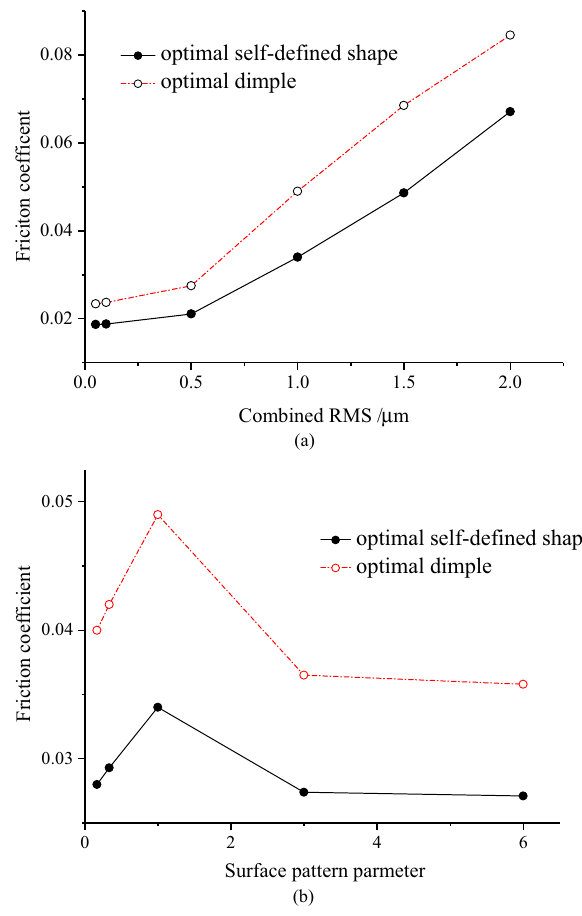
Figure 4. ( a ) Variation of the optimal friction coefficient with combined RMS; ( b ) Variation of the optimal friction coefficient with surface pattern